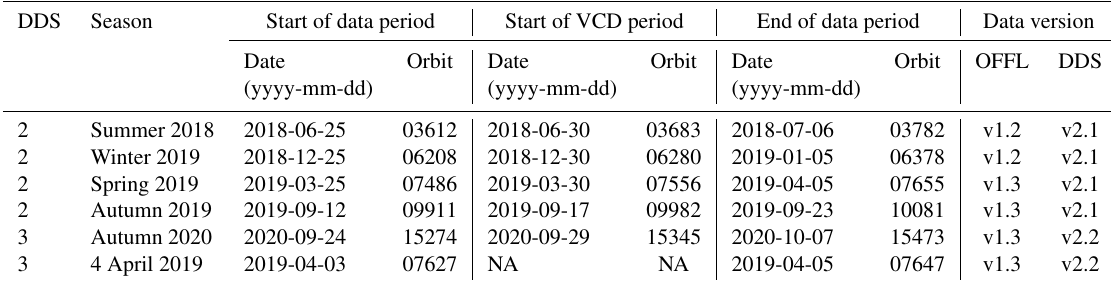
Table 1. Overview of the diagnostic dataset (DDS) periods processed for evaluation of the updated NO 2 data. Columns 3 and 4 give the start of the data that were processed. Columns 5 and 6 give the start of the data that are used for the analysis of the vertical column density (VCD), i.e. after a spin-up period needed by TM5-MP. Columns 7 and 8 give the end of the data that were processed. Note that the orbit at the start of a period may have a sensing start time just before midnight preceding the given date. The last two columns give the version number of the publicly released offline (OFFL) and DDS